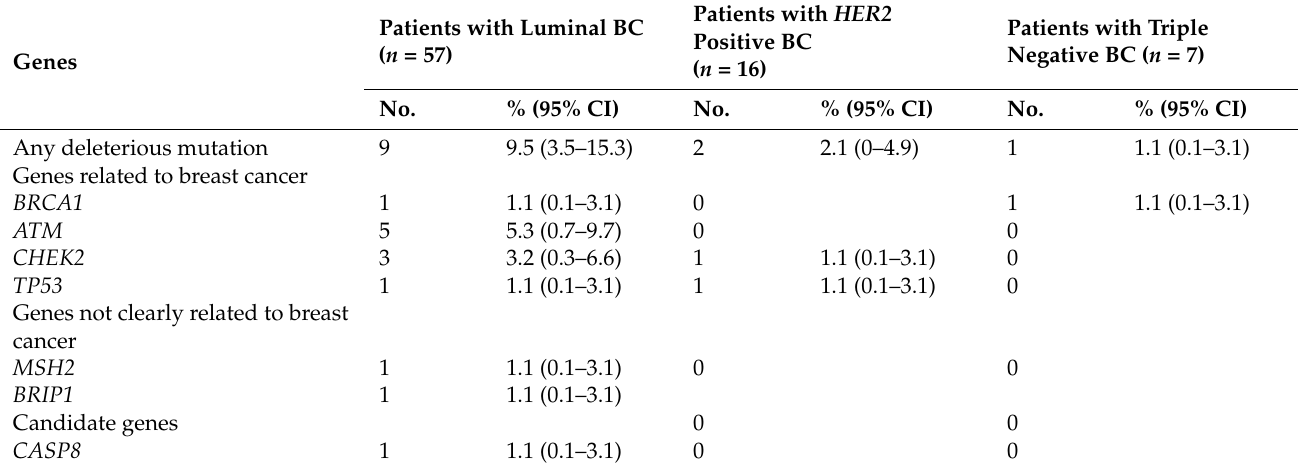
Table 4. Deleterious mutations by breast cancer (BC)